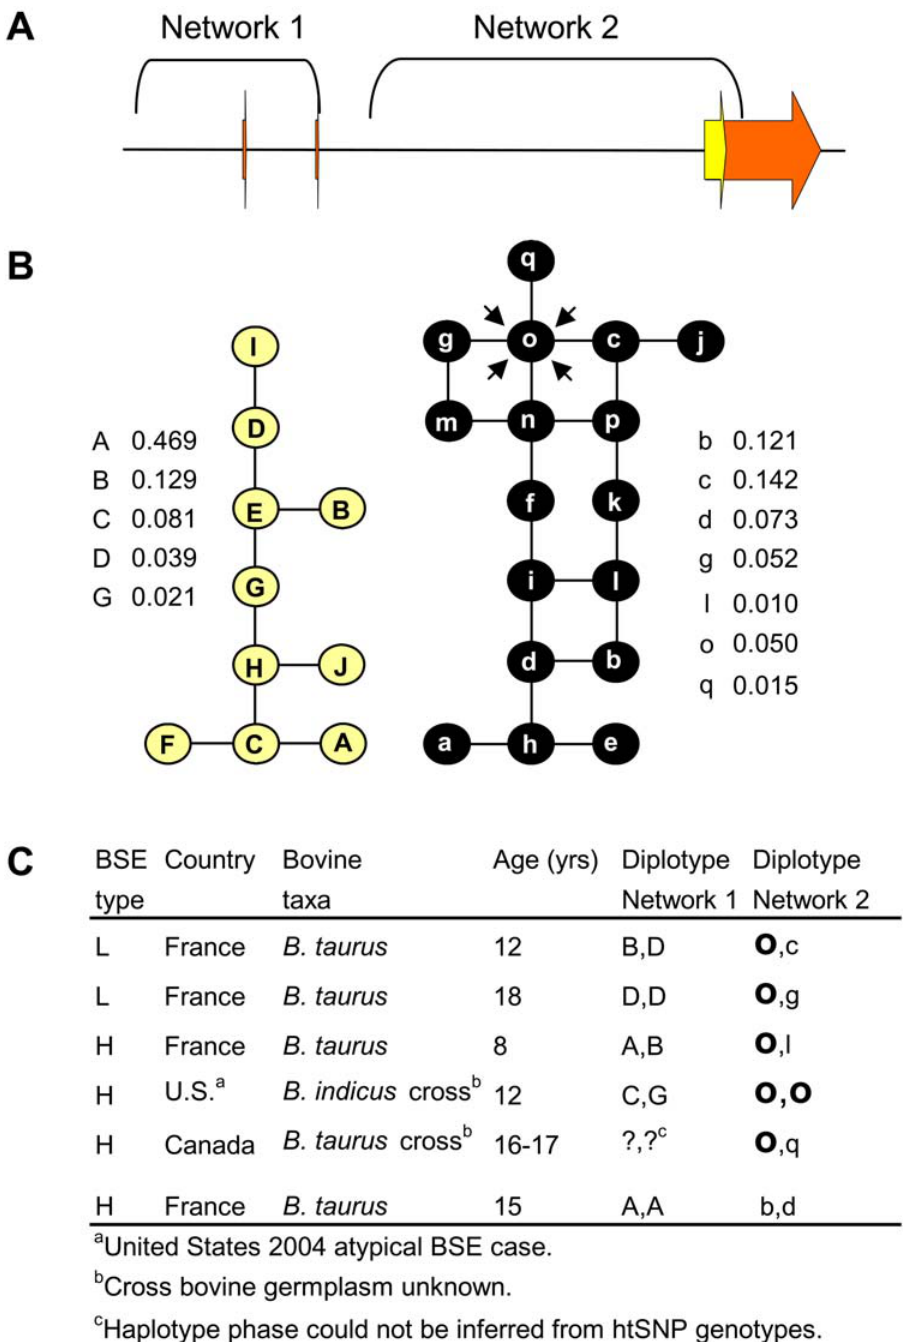
Figure 1. Prion haplotypes of atypical BSE cases. (A) Physical map of bovine PRNP . Orange and yellow arrows represent untranslated and protein coding regions, respectively. PRNP regions spanned by prion haplotypes are indicated by brackets labeled network 1 and network 2. (B) PRNP haplotype relationships and frequencies in U.S. cattle. Haplotypes in network 1 are represented as yellow circles, are defined by 9 htSNPs and span a portion of the PRNP promoter, exon 1, intron 1, exon 2, and a small portion of intron 2 (6.3 kb). Haplotypes in network 2 are represented as black circles, are defined by 10 htSNPs and span most of intron 2, the entire coding region, and a portion of the 3 9 UTR of PRNP (13 kb). Numbers represent the frequencies of PRNP haplotypes in the control group of U.S. cattle. (C) Atypical BSE case information. BSE type, country of origin, bovine taxa, age, and PRNP diplotyes of the atypical BSE cases.